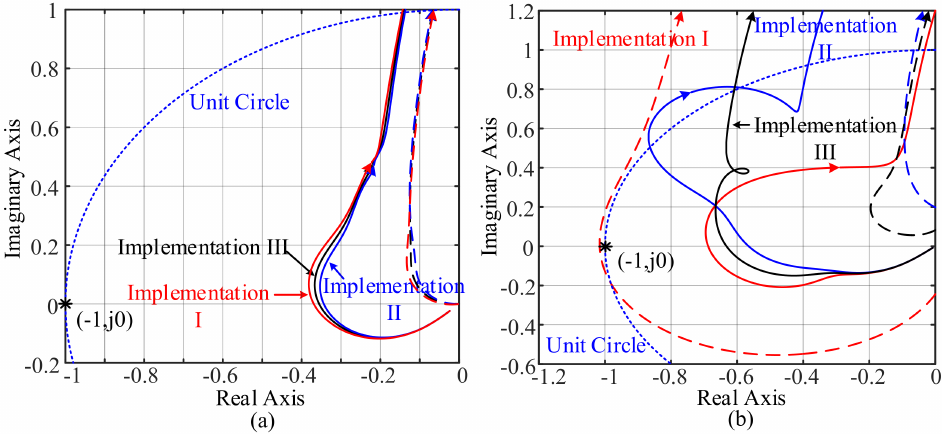
Figure 8. Nyquist curves of characteristic loci of L αβ with different implementations of the adaptive resonance controllers using ( a ) DSOGI-FLL; ( b ) SRF-PLL for grid synchronization. Solid line: λ 1 ( s ); Dash line: λ 2 ( s ).